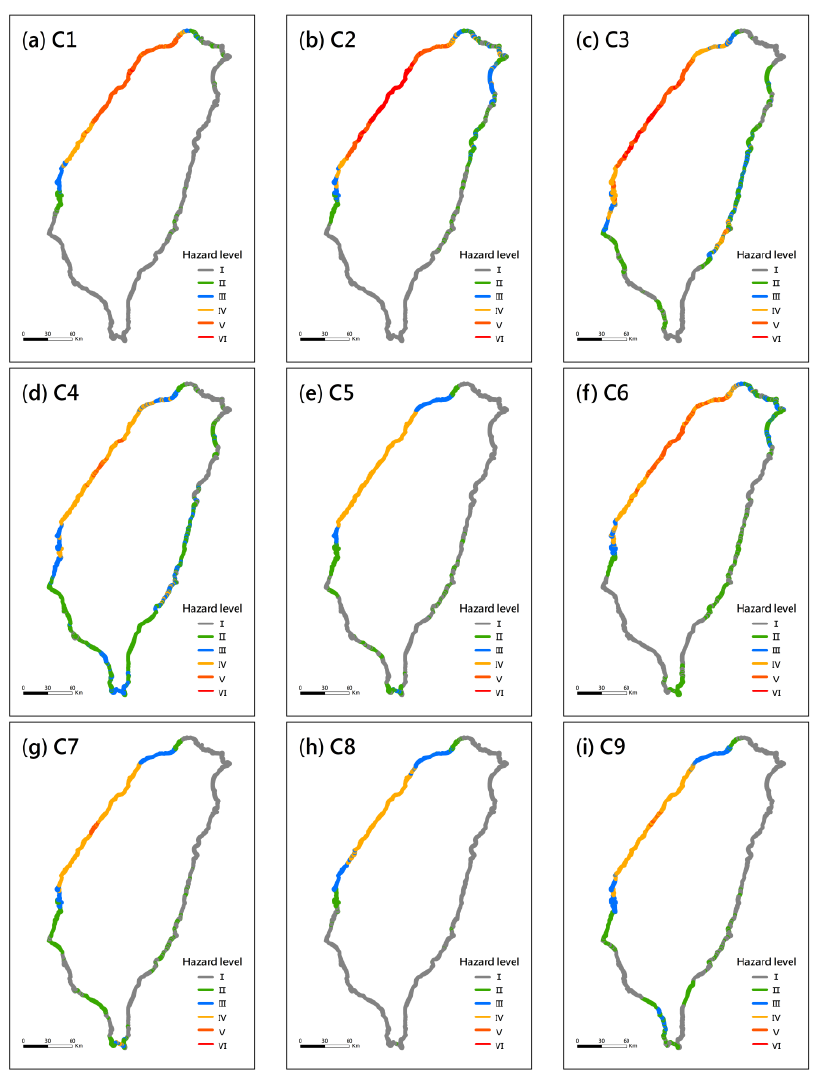
Figure 10. The potential highest storm tide (HST) hazard maps for C1–C9. ( a ) category 1, ( b ) category 2, ( c ) category 3, ( d ) category 4, ( e ) category 5, ( f ) category 6, ( g ) category 7, ( h ) category 8 and ( i ) category 9.